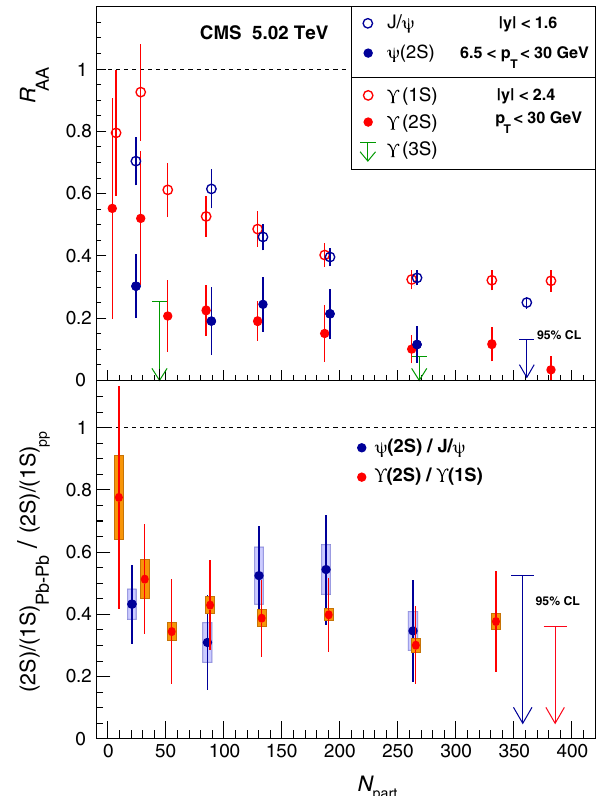
Fig. 2 Top: nuclear modification factor as a function of centrality for the (inclusive) J /ψ , ψ( 2S ) , Υ ( 1S ) , Υ ( 2S ) and Υ ( 3S ) quarkonia, as measured by CMS comparing pp and Pb–Pb data at 5.02TeV [12,13]. Bottom: corresponding double ratio of the 2S and 1S nuclear modifica- tion